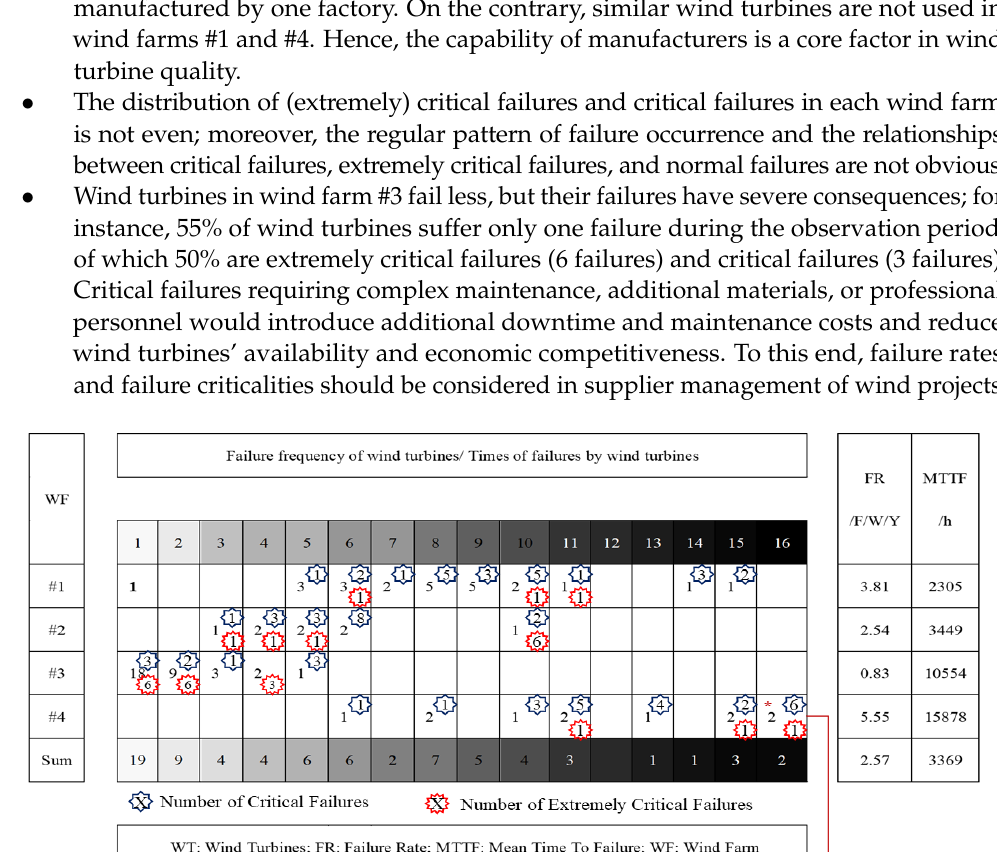
Table 5. The statistic of critical and extremely critical failures (per year).